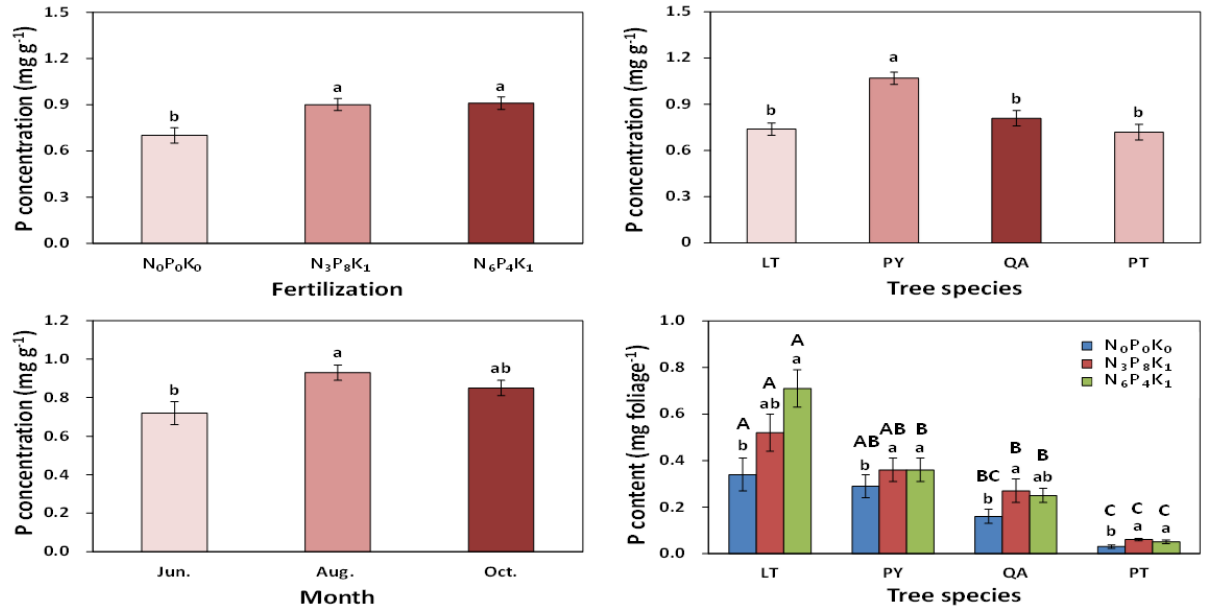
Figure 7. Phosphorus concentration and content of foliage by fertilization, tree species, and sampling month in a fire-disturbed urban forest (mean ± standard error). Treatment means with the same lower case letter among fertilizer, tree species or sampling month treatments and treatment means with the same upper case letter among tree species are not significantly different at p < 0.05. LT: Liriodendron tulipifera L.; PY: Prunus yedoensis Matsumura; QA: Quercus acutissima Carruth; and PT: Pinus thunbergii Parl .